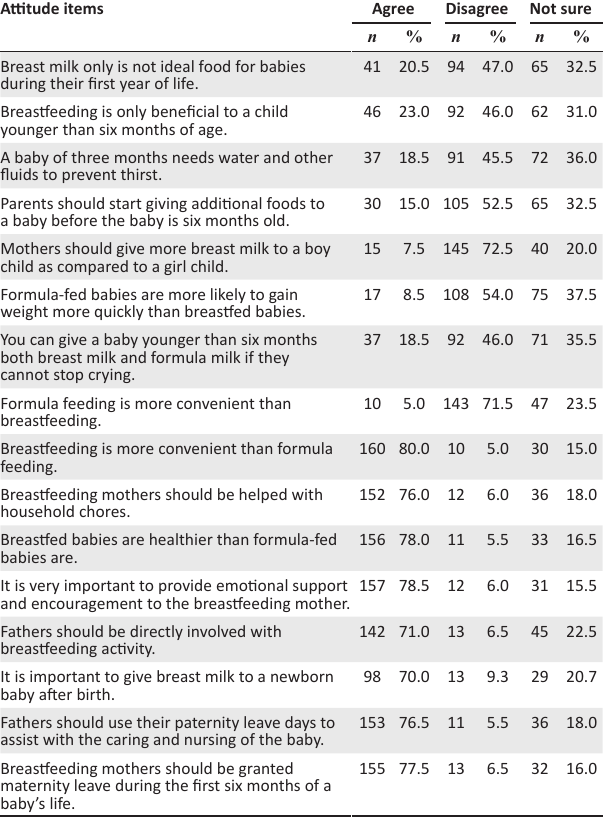
TABLE 3: Participants’ attitudes towards exclusive breastfeeding.